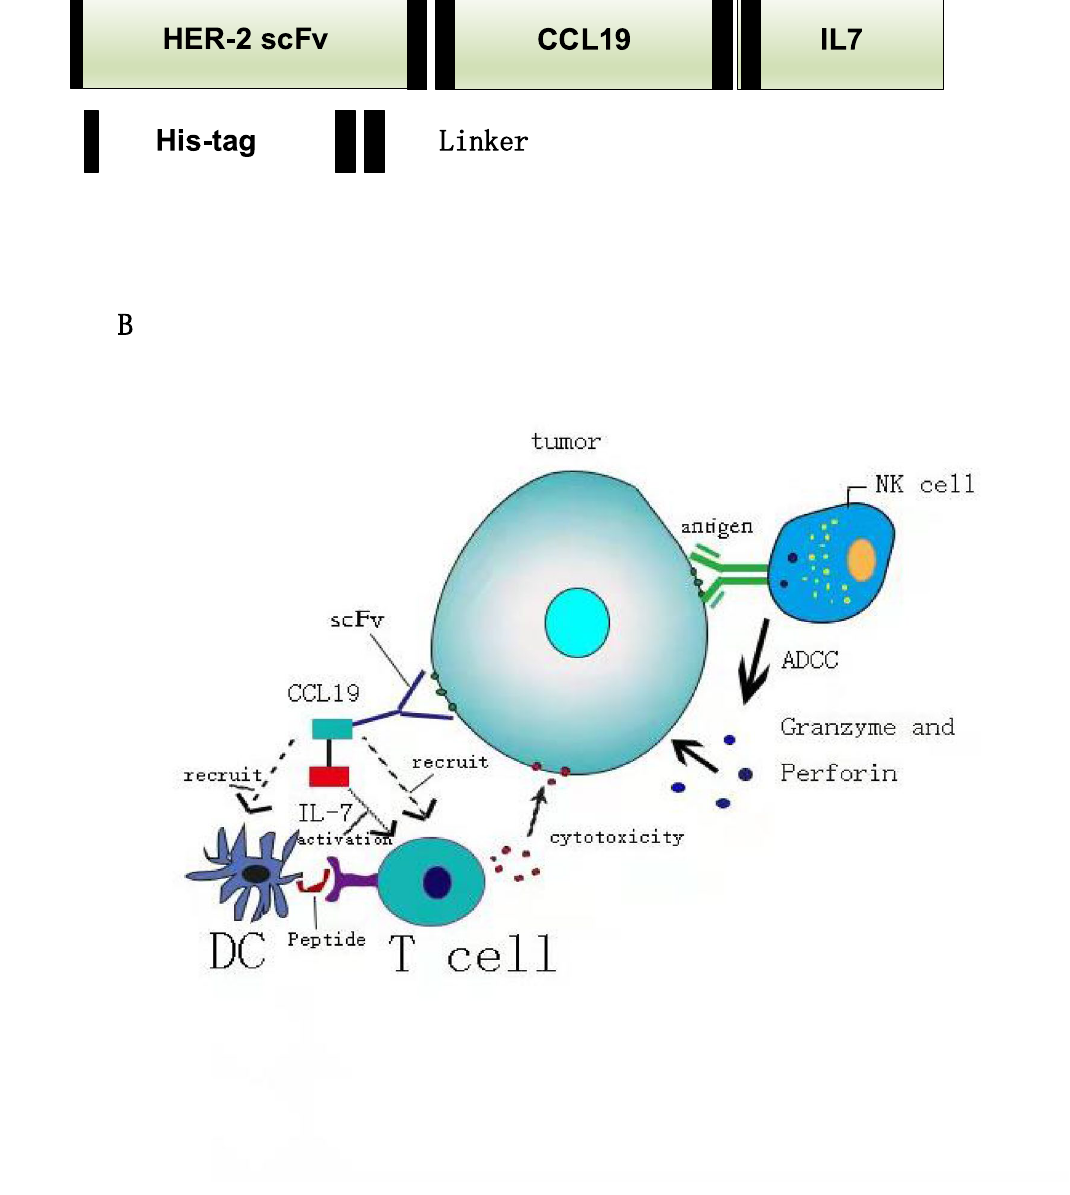
Figure 1. Schematic diagram of the HCI fusion protein killing effects. ( A ) Illustrative representation of the HCI fusion protein construct. ( B ) Schematic diagram of the HCI fusion protein killing effects when targeting HER-2 antigen positive tumor cells. Unlike the ADCC effects which mainly induced by NK cells, the HCI protein can recognized the HER-2 antigen(the function of HER-2 scFv) and recruit DC and T cells to infiltrated to the tumor site (the function of CCL19 part)and activated the effector cell (the function of IL-7 part and the DC cells which recruit by the PBMCs from the interphase were collected, washed with complete medium three times and then cultured in RPMI-1640 complete medium supplemented with 10% FBS at 37 ℃ with 5% CO 2 overnight. Flow cytometry analysis. For flow cytometry analysis, BD FACS (Fluorescence-Activated Cell Sorting) Aria II (BD Bioscience) was used. HER-2 protein expressed on NCI-N87 and SGC7901cells was detected with FITC-labeled mouse anti-HER2 lgG1 antibody (Santa Cruz, USA); the isotype control group was stained with FITC-labeled lgG1 (Santa Cruz, USA). The binding capability of the HCI fusion protein to HER-2-positive tumor cells was determined as follows: 1 × 10 6 NCI-N87 or SGC7901 cells were harvested and placed in a 2 ml tube and washed 3 times with 3 ml of ice-cold PBS containing 4% BSA (bovine serum albumin). After washing, the cells were resuspended in 200 μl